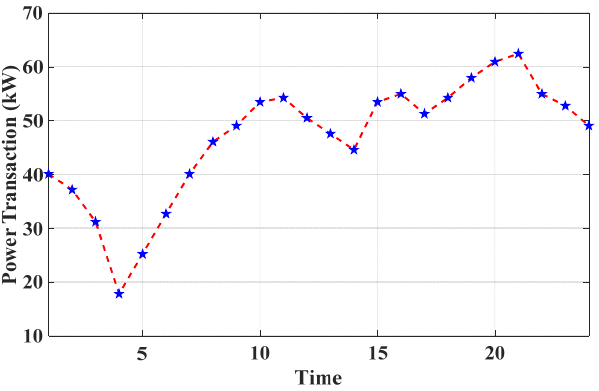
Figure 3. The generated powers of AC units including wind and tidal turbines.